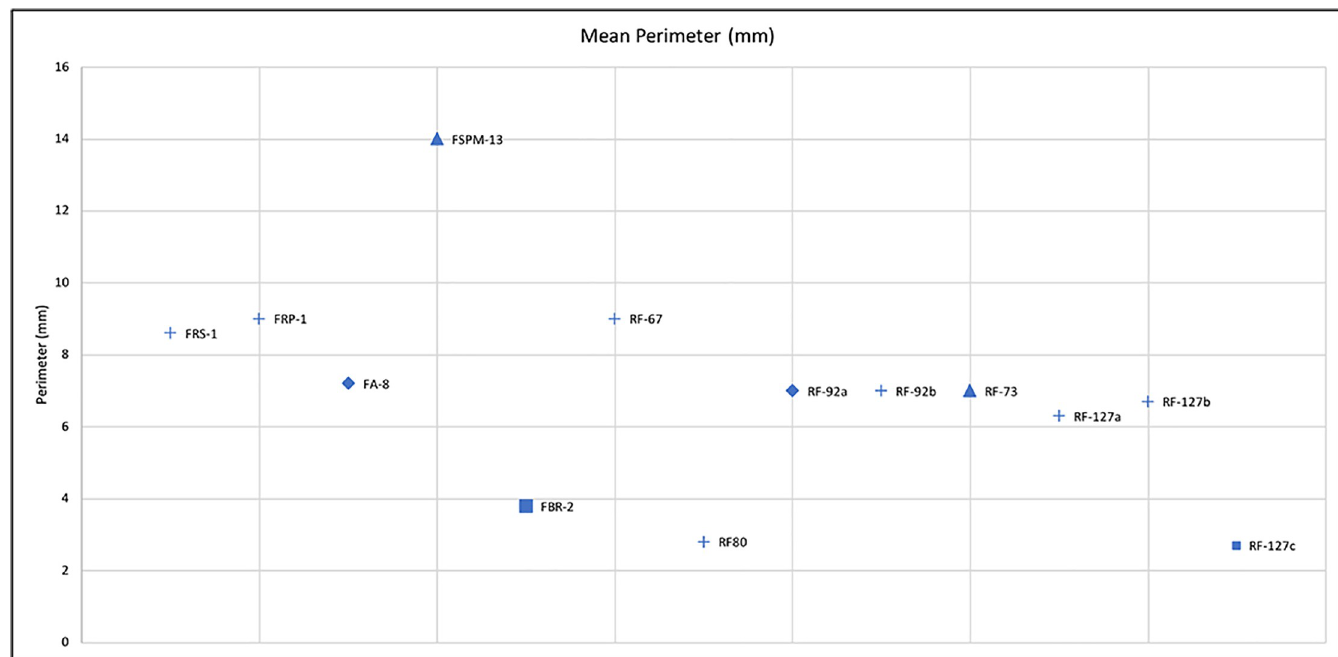
Fig 32. Comparison between the mean perimeter of the wear identified on the experimental and archaeological specimens. In detail, crosses = retouch activities; diamonds = bipolar percussion; triangles = striking platform management; square = bladelets